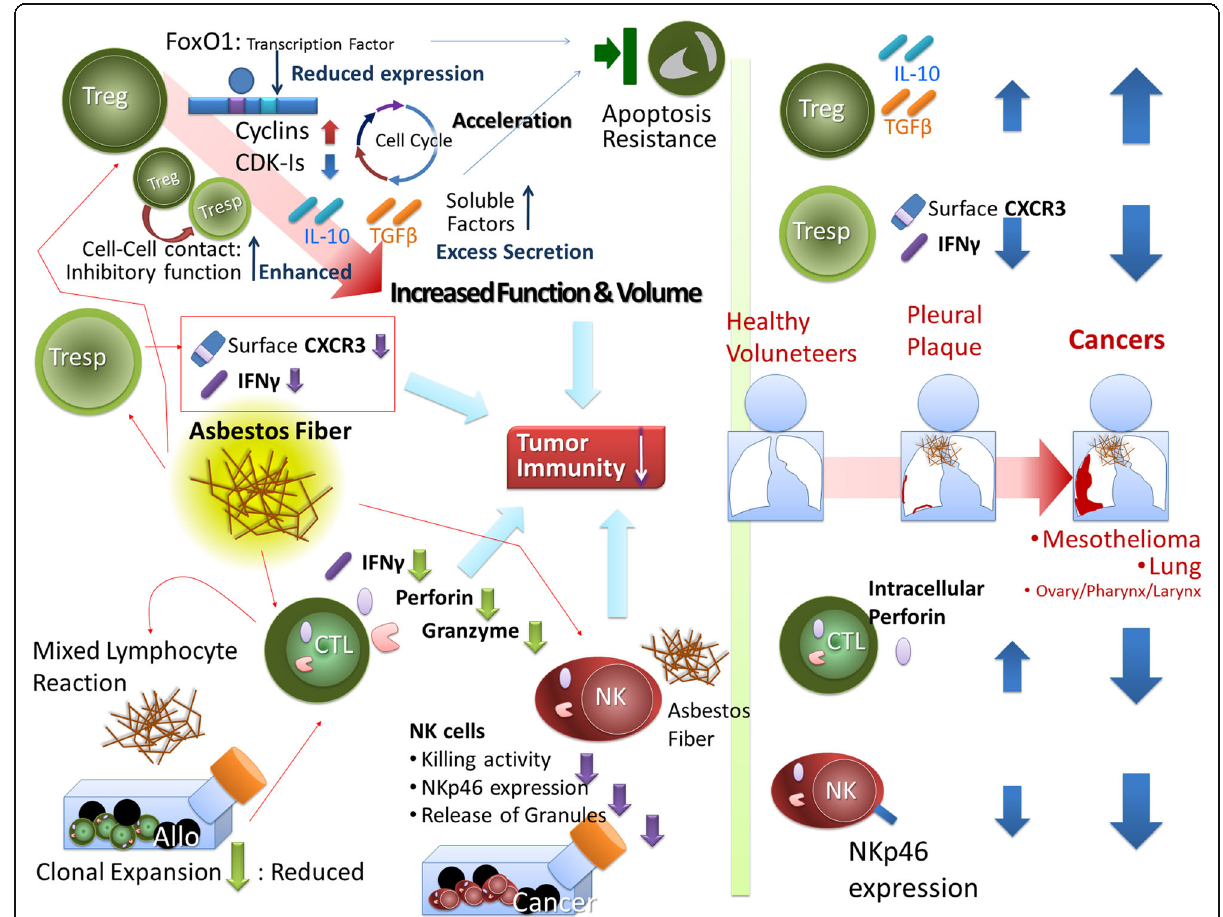
Fig. 1 Schematic presentation of the immunological effects of asbestos exposure on various lymphocytes such as regulatory T cells ( Treg ), responder CD4+ T helper cells ( Tresp ), CD8+ cytotoxic T lymphocytes ( CTL ), and natural killer ( NK ) cells. All of the findings described in this review indicate that asbestos exposure impairs antitumor immunity, as shown in the left panel of the figure. These findings can be used to explore biological marker candidates, as shown in the right panel of the figure, and suggest the usefulness of serum/plasma IL-10 and TGF- β , surface CXCR3 expression in Tresp, secreting potential of IFN- γ in Tresp, intracellular perforin level in CTL, and surface expression of NKp46 in NK cells. Although other unexplored cytokines in serum/plasma and molecules in these immunological cells and Th17 should be investigated, including a comprehensive analysis of screening methods, biomarkers based on immunological alterations may helpful in the clinical situation to screen the high-risk population exposed to asbestos and to detect and treat asbestos-related cancers such as